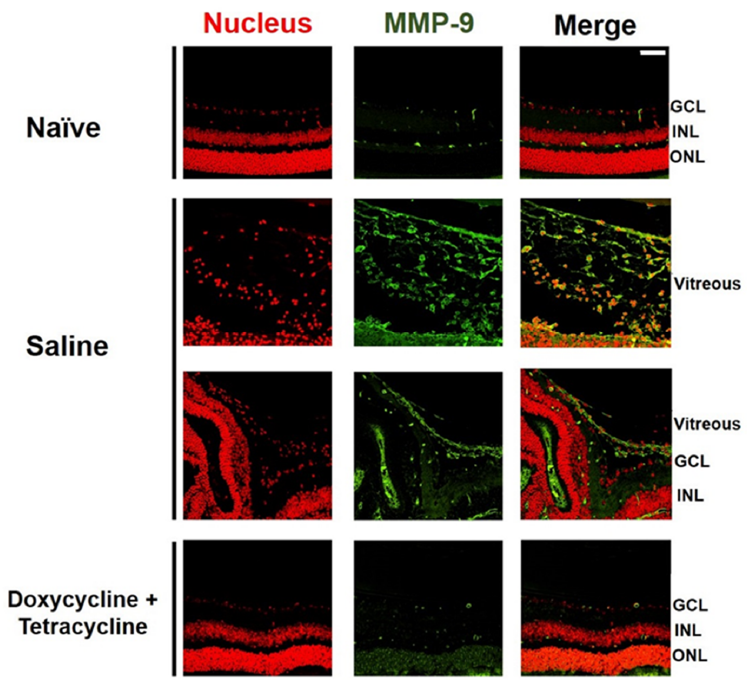
Figure 4. Doxycycline and tetracycline treatment decreases MMP-9 expression in the retina and vitreous of mice after PVR induction. The eye sections of naïve mice or mice with PVR induction and treated with saline or doxycycline and tetracycline were subjected to immunofluorescence staining with DAPI for the nucleus (red) and the antibody against MMP-9 (green) 21 days after induction. GCL: ganglion cell layer; INL: inner nuclear layer; ONL: outer nuclear layer. Scale bar, 50 μm. Data are the representative of at least 2 experiments.